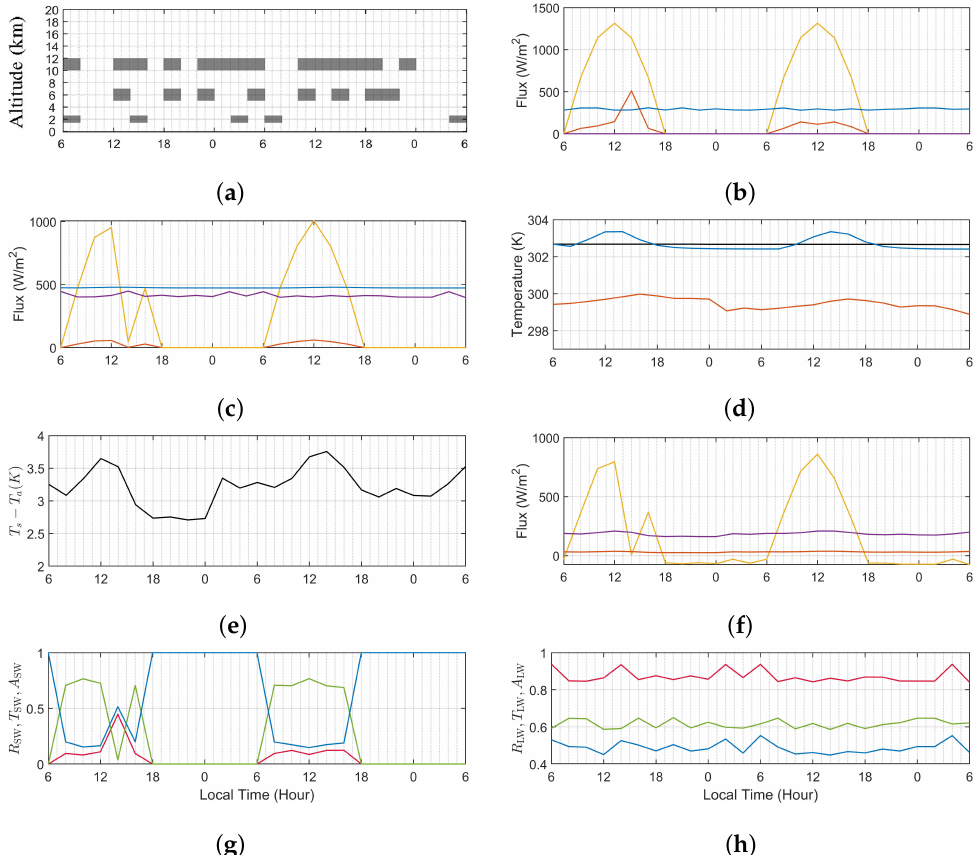
Figure 10. Simulation data over 48 h (d1h6-d3h6) in post-hiatus period, ( a ) cloud pattern, ( b ) flux